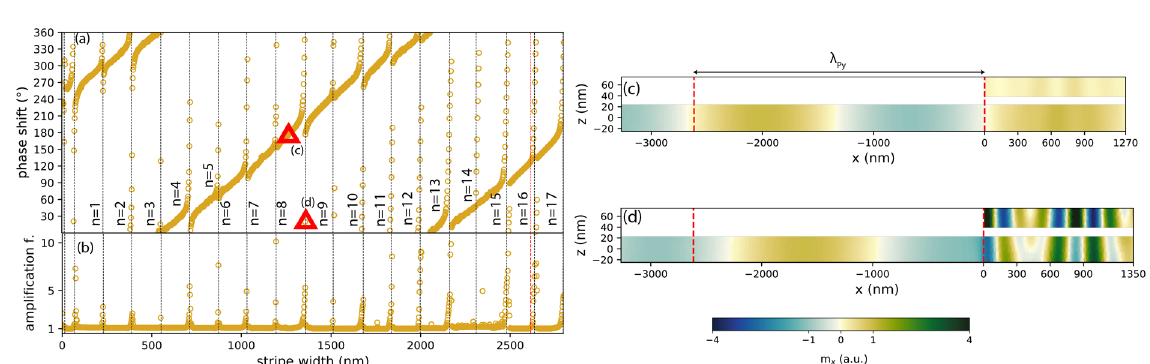
Figure 4. ( a ) Incident and reflected plane waves at an arbitrary time, and resulting interference pattern, in the zero phase shift case, i.e., ϕ = 0 ◦ . The dotted orange line and the dashed blue line correspond to the incident and reflected plane waves, respectively. The solid green line corresponds to the interference pattern. ( b ) The same for a phase shift of ϕ = 230 ◦ , i.e., the value obtained for SW reflection from the edge of a semi-infinite 50-nm-thick Py film.